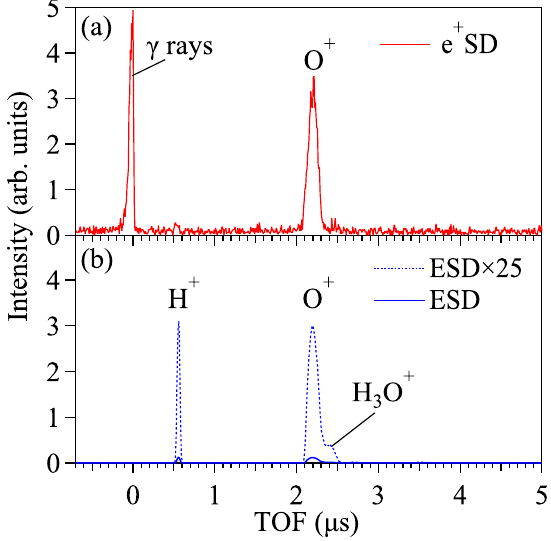
Figure 1. TOF spectra of ions desorbed from a TiO 2 (110) surface by ( a ) positron and ( b ) electron bombardment at an incident energy of 500 eV. Each spectrum was normalised to the number of incident particles. The blue dashed line in ( b ) indicates ESD results enlarged by a factor of